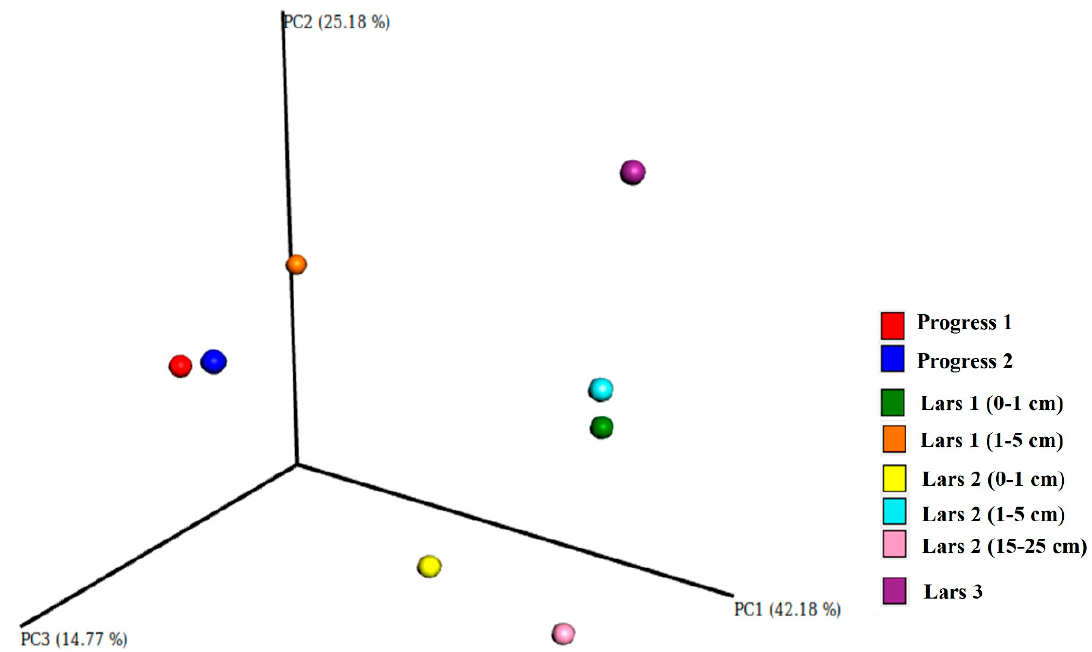
Figure 4. PCoA analysis of weighted UniFrac distance matrix representing β -diversity of the prokaryotic communities. PC1, PC2 and PC3 are the main coordinate axes of the multidimensional space, with the values of the explained variance (percentage).